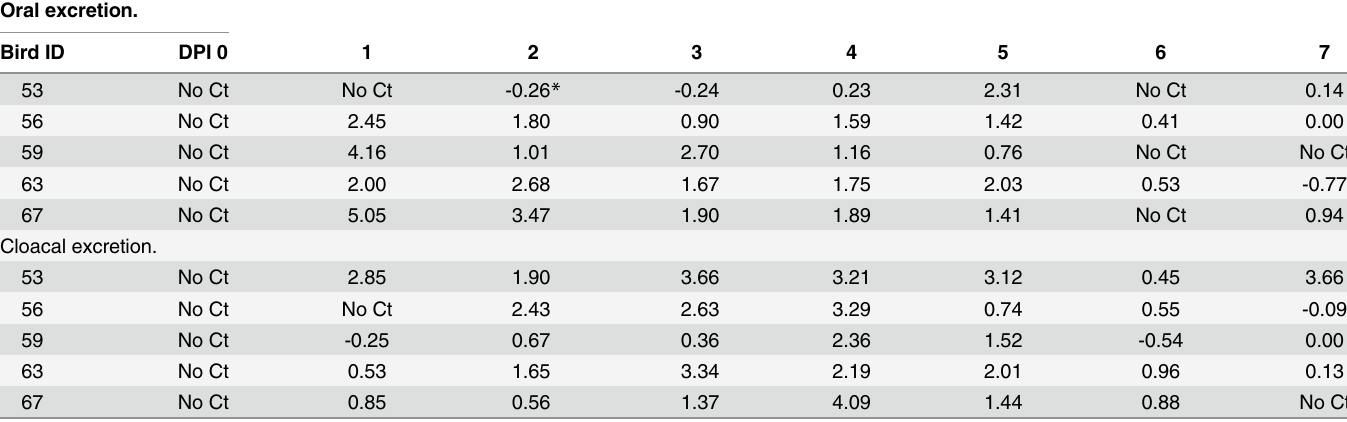
* Values are based on quantitative RT-PCR analysis and expressed as Log 10 EID 50 /ml. doi:10.1371/journal.pone.0144524.t006 any swab sample after 7 DPI and none of the challenged birds exhibited clinical signs of disease or infection. Parameter estimates from regression models of the two virus challenge cohorts indicated